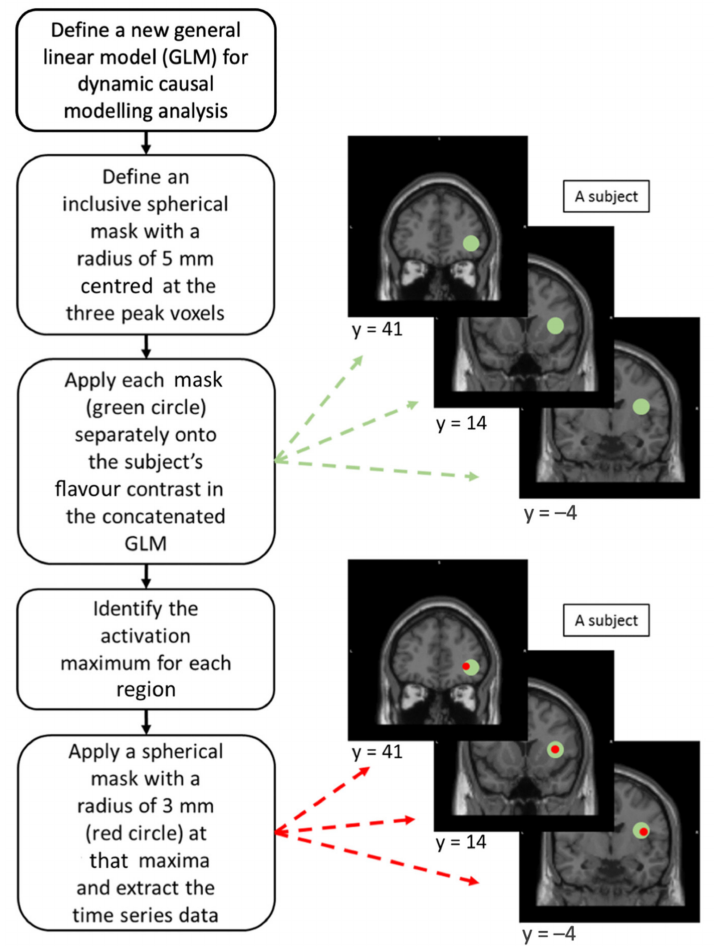
Figure 2. Illustrations on the procedures of volume of interest (VOI) extractions in dynamic causal modelling (DCM) analysis for individual